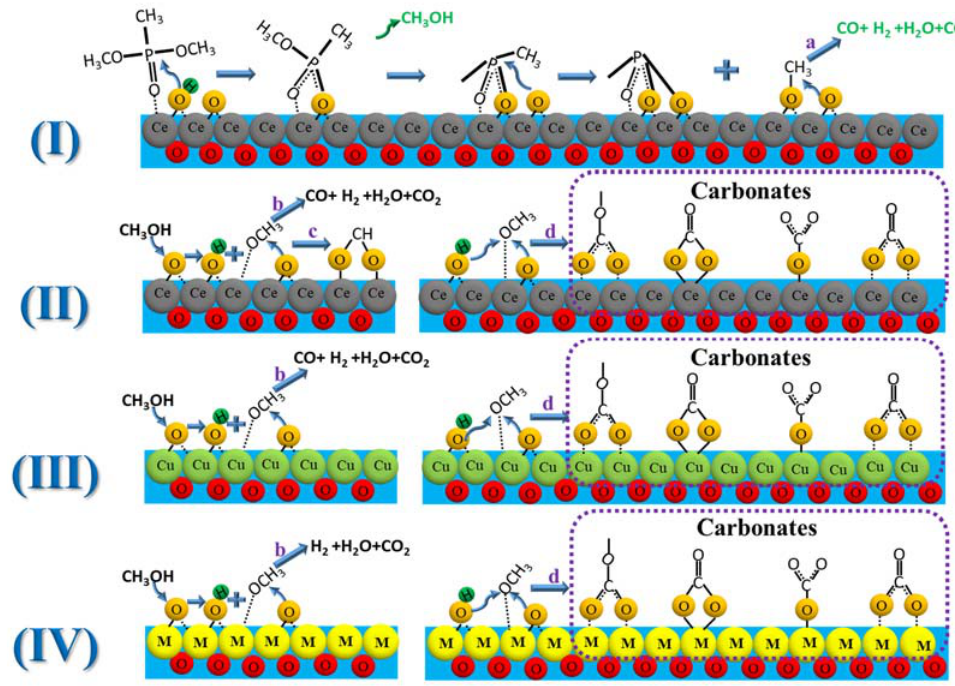
Scheme 1. Proposed reaction pathways for the decomposition of DMMP, ( Ⅰ ) the main reaction path ‐ way for the decomposition of DMMP on CeO 2 , ( Ⅱ ) the side reaction pathways for the decomposition of DMMP on CeO 2 ; ( Ⅲ ) the side reaction pathways for the decomposition of DMMP on CuO; ( Ⅳ ) the side reactions pathways for the decomposition of DMMP on CuO/CeO 2 (M: Cu or Ce).